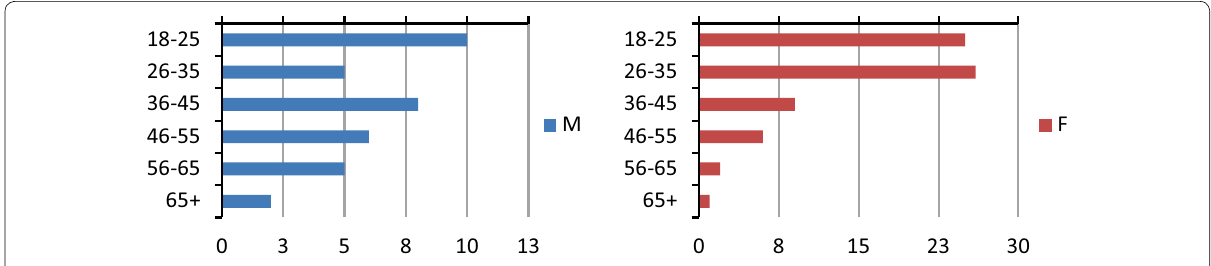
Fig. 1 Relative frequencies of age classes among male ( left panel ) and female ( right panel )